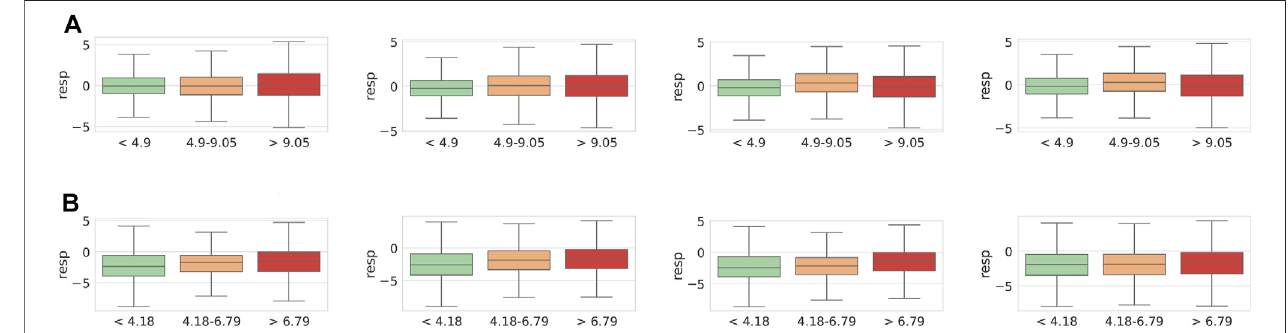
FIGURE 13 | Box plots of predicted respiration values for the FAU-TSST (A) and REG-TSST (B) datasets. Grouped based on raw cortisol (nmol/L) measures taken at time points